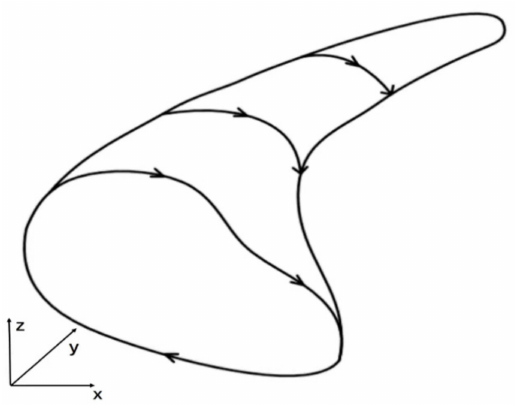
Figure 9. Schematic of vortex E with “L”